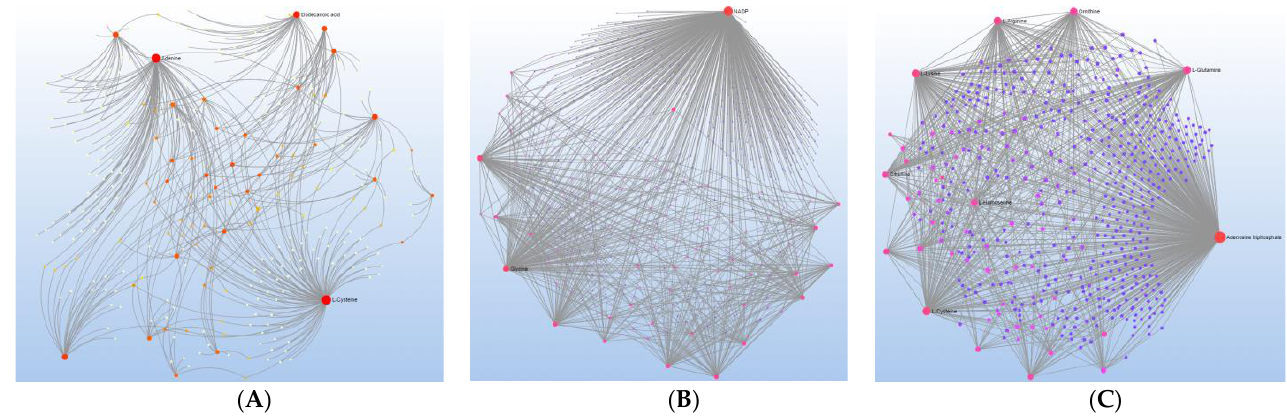
( A ) ASD (28 significant pathways) ( B ) Epilepsy (31 significant pathways) Figure 4. Major Nodes for Metabolite–Metabolite Interaction Networks for ( A ) ASD, ( B ) epilepsy (EPI) and ( C )